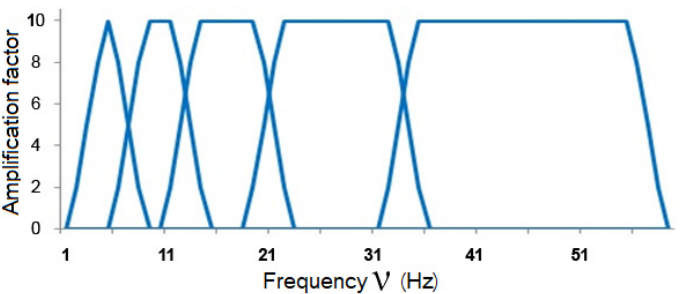
Figure 1. Frequency domains of